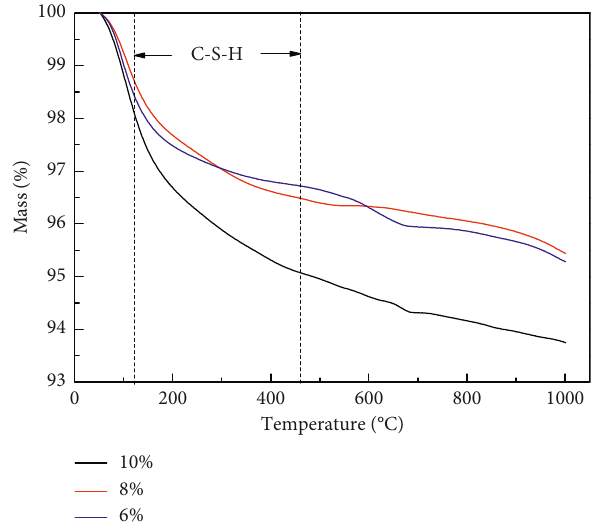
Figure 5: Thermogravimetry curves of CNSCMs with different SS contents and a curing time of 28d.